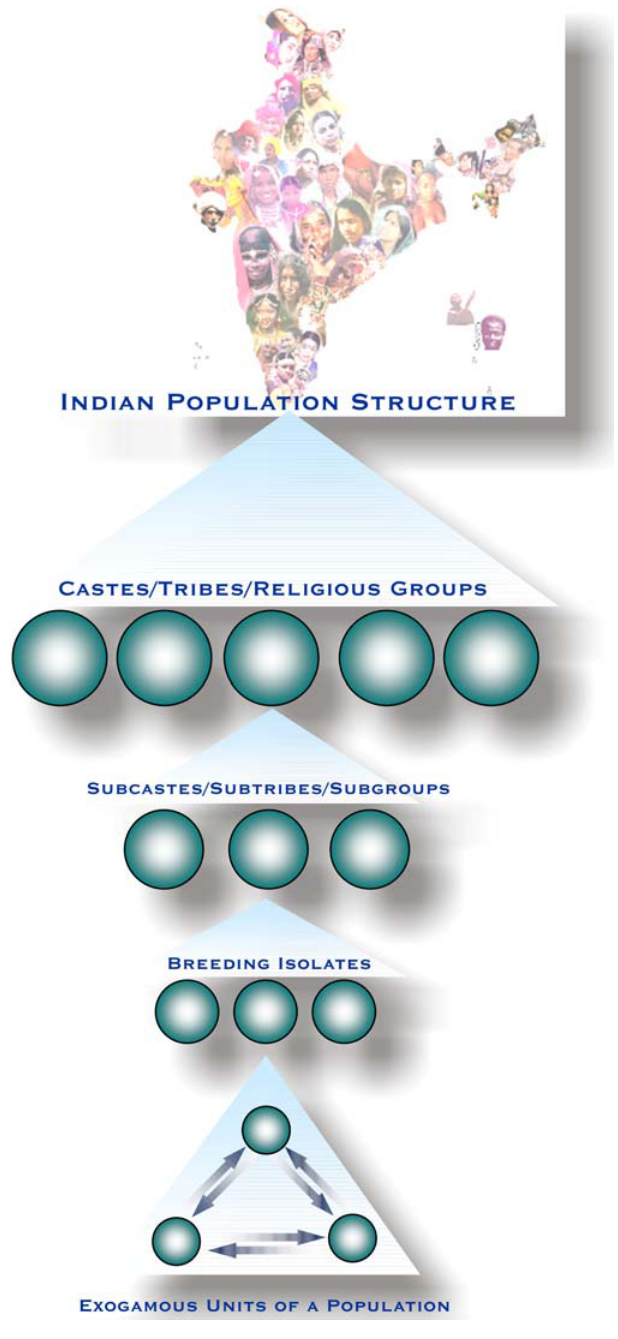
Figure 1. Schematic Representation of Indian Population Structure Characterized by Movement of Spouses Only within but Not among the Endogamous Groups Each circle represents a population and its size represents the hierarchy. While the populations until the breeding isolates are all endogamous, the exogamous units refer to clans/lineages within a breeding isolate/